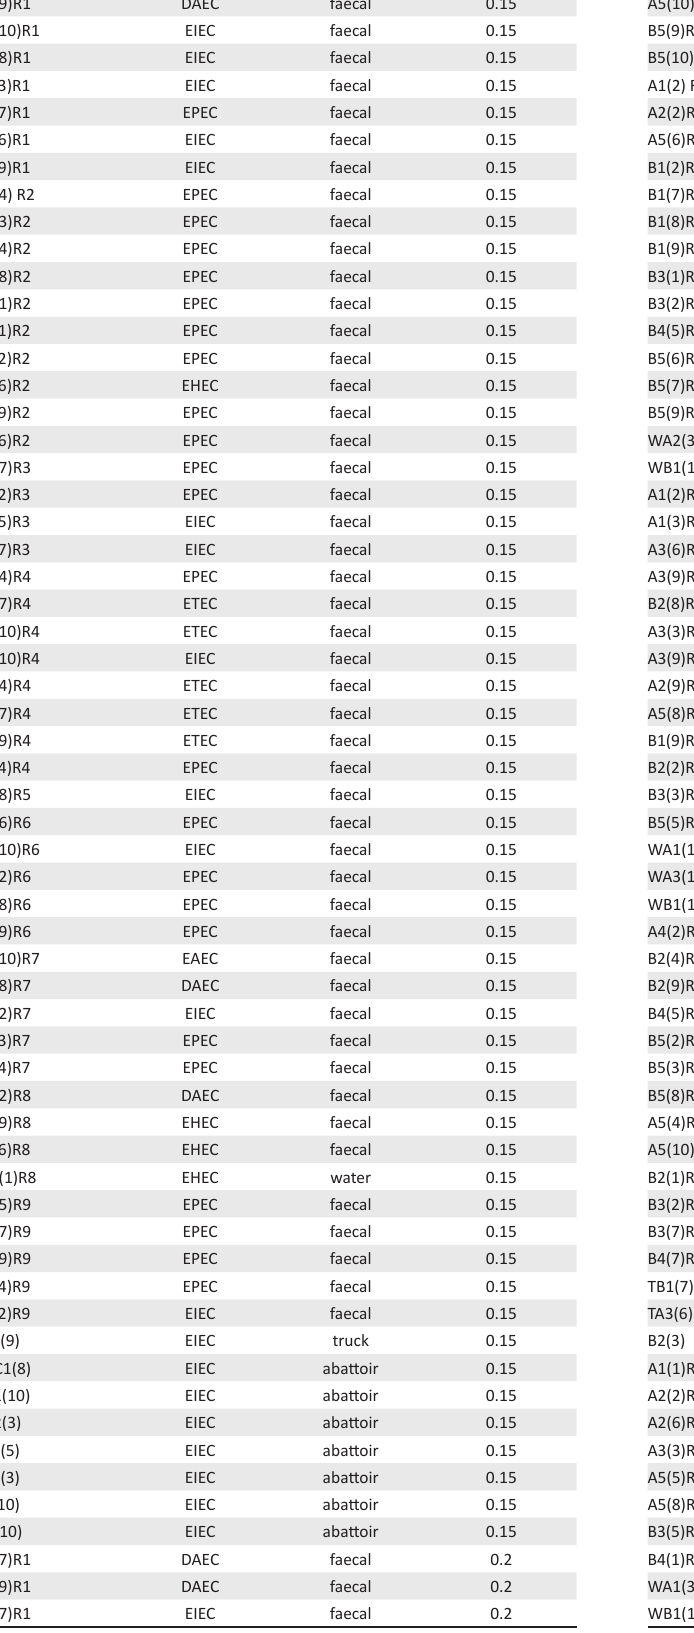
TABLE 4-A1 (Continues...): Multiple-antibiotic resistance index for all diarrheagenic E. coli pathotypes along the farm-to-fork continuum. Bacterial ID DEC pathotype